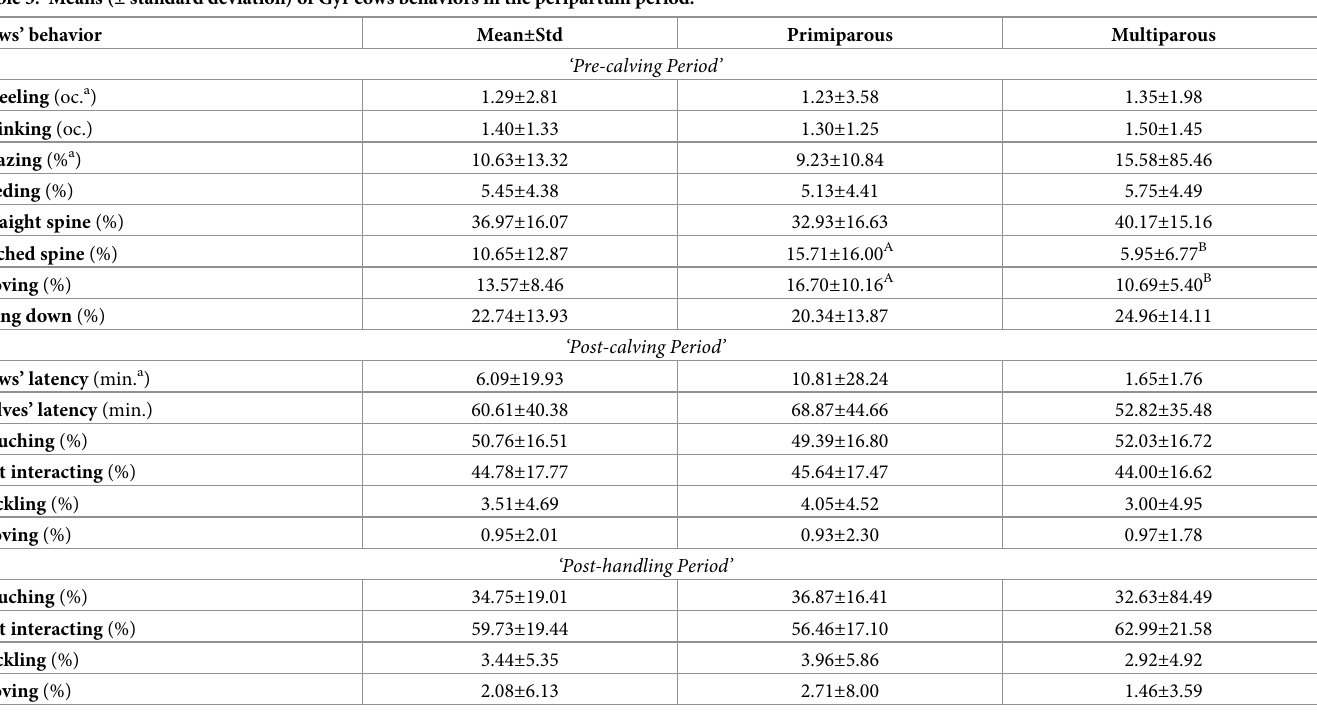
Table 3. Means ( ± standard deviation) of Gyr cows behaviors in the peripartum period. Cows’